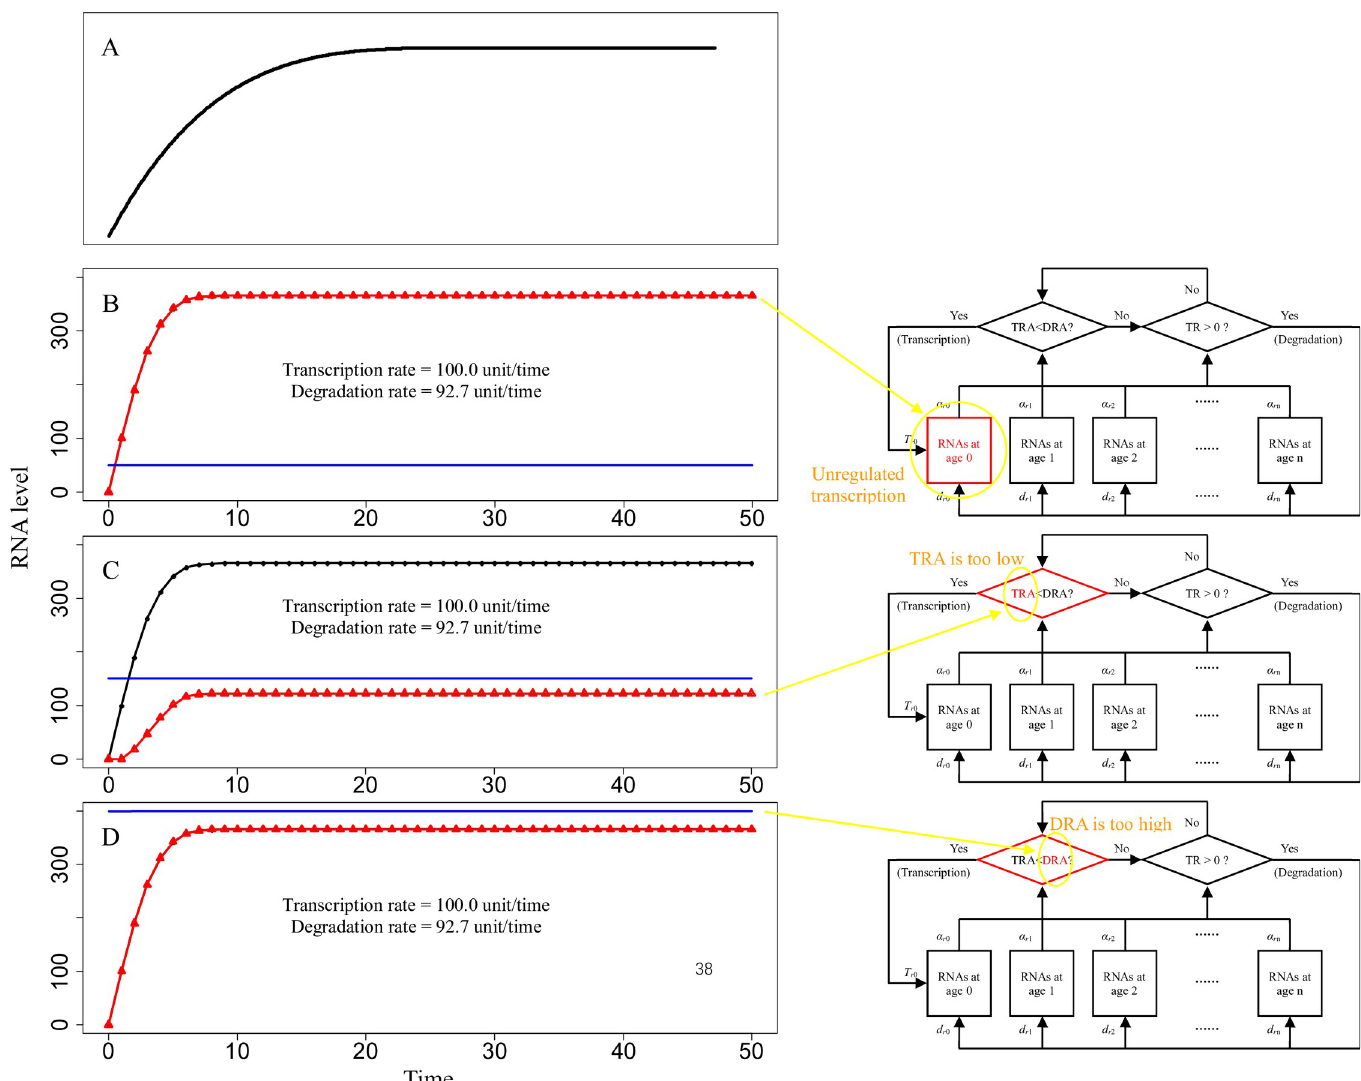
Fig 4. Stable RNA levels. Blue line represents the demand for RNA activity (DRA). Black curve represents the total amount of RNA (TR), and points on the line are predicted values. Red curve represents total RNA activity (TRA), and triangles on the curve are predicted values. d α r 0 , α r 1 , α r 2 , ... , α r n are the activity coefficients of RNA. T r 0 is the amount of nascent RNA per time. The x-axis is time, and the unit of time is RNA age, which is standardized as unitless values. The y-axis is the RNA level, which is standardized as unitless values. (A) Validation data: stable RNA level reported in the literature [11,21,38],as shown inS1B Fig. (B) Transcription is unregulated. TR and TRA curves overlap (DRA is 50. The level of the transcripts at age 0 is 100 per transcript during the whole experiment. The survival rate decreases at older RNA ages, i.e., the type B RNA survival rate is shown in S2 Table. The RNA activity coefficient of each RNA age is 1, i.e., the type A RNA activity coefficient in S2 Table). (C) TRA that is too low (DRA is 150. If TRA < DRA, then RNA level at age 0 = 100; otherwise, RNA level at age 0 = 0. The survival rate decreases at older RNA ages, i.e., the type B RNA survival rate is shown in S2 Table. The RNA activity coefficient has a parabolic trend, i.e., the type C RNA activity coefficients in S2 Table). (D) DRA that is too high. TR and TRA curves overlap (DRA is 400. If TRA < DRA, then RNA level at age 0 = 100; otherwise, RNA level at age 0 = 0. The survival rate decreases at older RNA ages, i.e., the type B RNA survival rate is shown in S2 Table. The RNA activity coefficient of each RNA age is 1, i.e., the type A RNA activity coefficient in S2